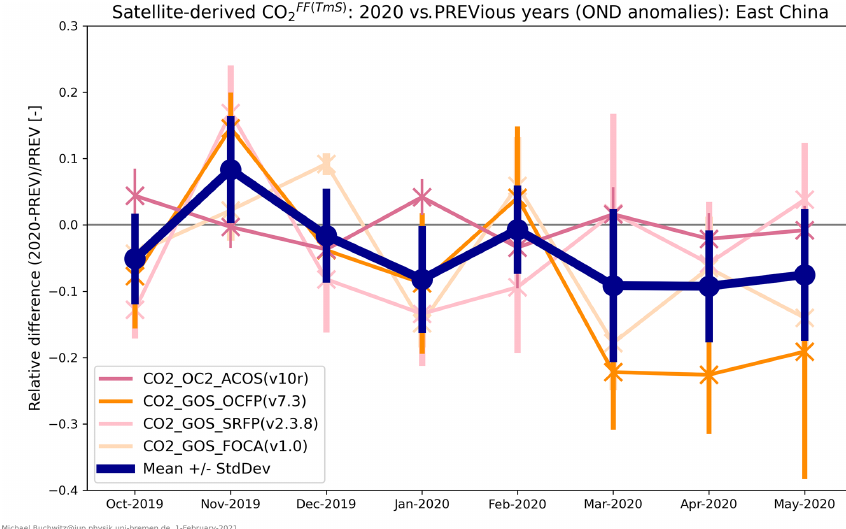
Figure A3. The same as Fig. 13 but using the TmS